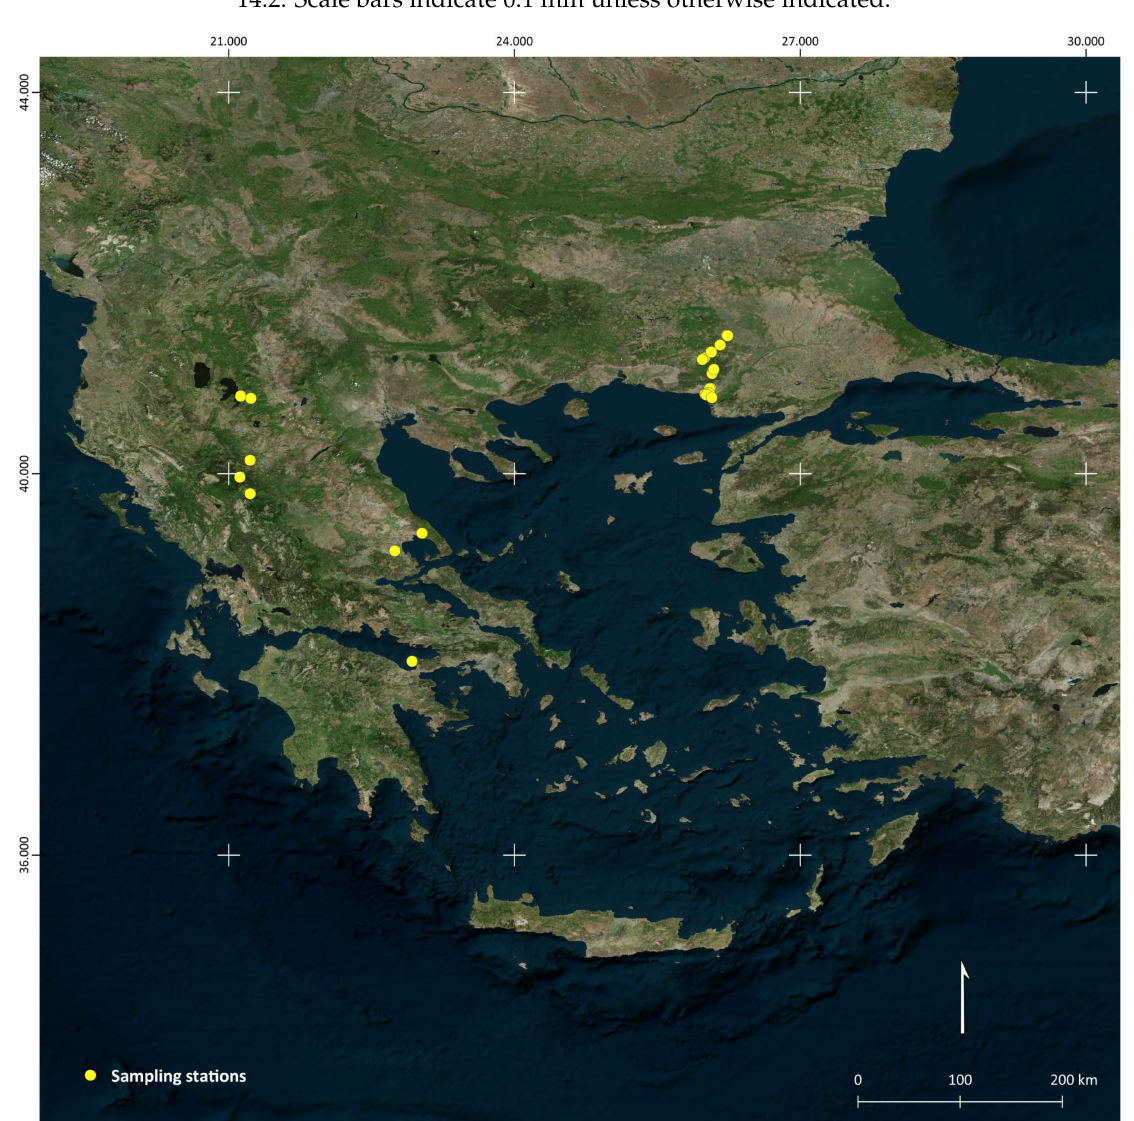
Figure 1. Map of sampling sites. Overview of Greece and sampling sites in the districts of Evros, Makedonia, Ipeiros, Magnisia, and